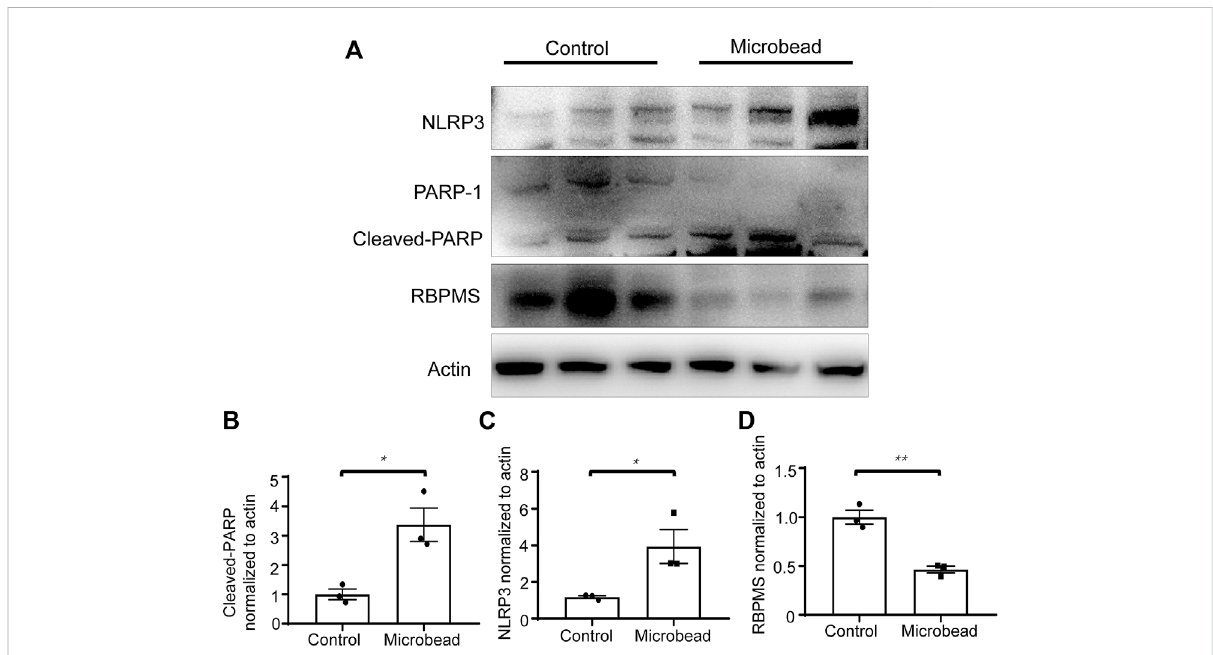
FIGURE 3 Chronic ocular hypertension decreased RBPMS and increased cleaved-PARP and NLRP3 expression. (A) Protein levels of RBPMS, cleaved- PARP, and NLRP3 were analyzed 28 days post-microbead injection. (B – D) RBPMS, cleaved-PARP, NLRP3, and actin bands were analyzed via densitometry using the ImageJ software, and the RBPMS/actin, cleaved-PARP/actin, NLRP3/actin ratios were quanti fi ed. The p -values were determined using an unpaired Student ’ s t-test for two-group comparisons. p p < 0.05 and pp p <